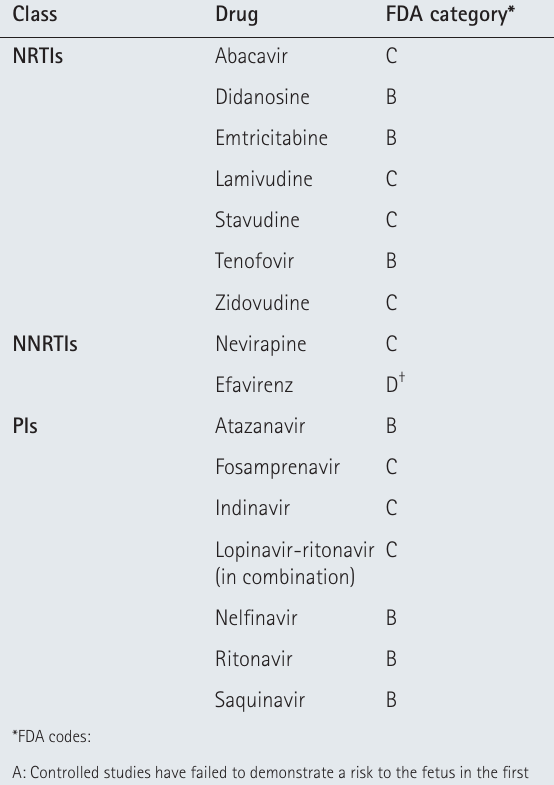
tAble iX. ARV teRAtoGeNic